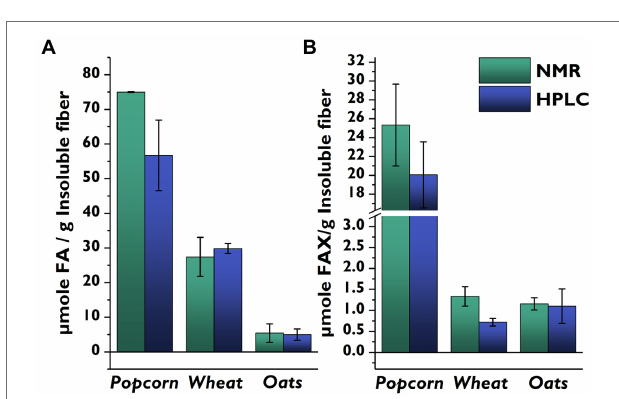
FIGURE 4 | Comparison of quantities of feruloylated side-chain compounds determined from identical insoluble fiber lots of whole cereal grains using the developed HSQC-NMR method vs. a previously published HPLC-based method. (A) : FA; (B) : FAX. Values represent the average ± standard deviation from triplicate determinations. FA, 5- O - trans -feruloyl- l -arabinofuranose; FAX, β - d -xylopyranosyl-(1 → 2)-5- O - trans -feruloyl- l -arabinofuranose; HPLC, high- performance liquid chromatography; NMR, nuclear magnetic